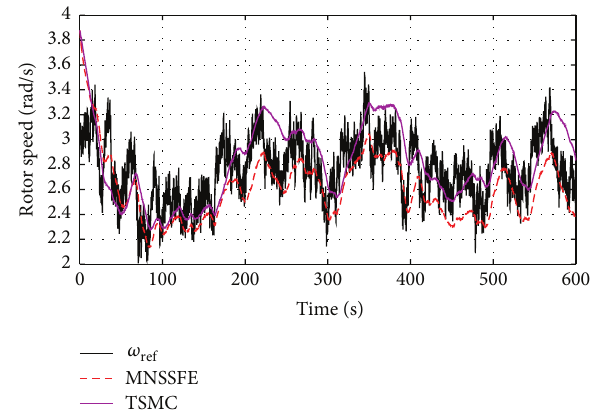
Figure 8: Rotor speed comparison for TSMC and MNSSFE for FAST